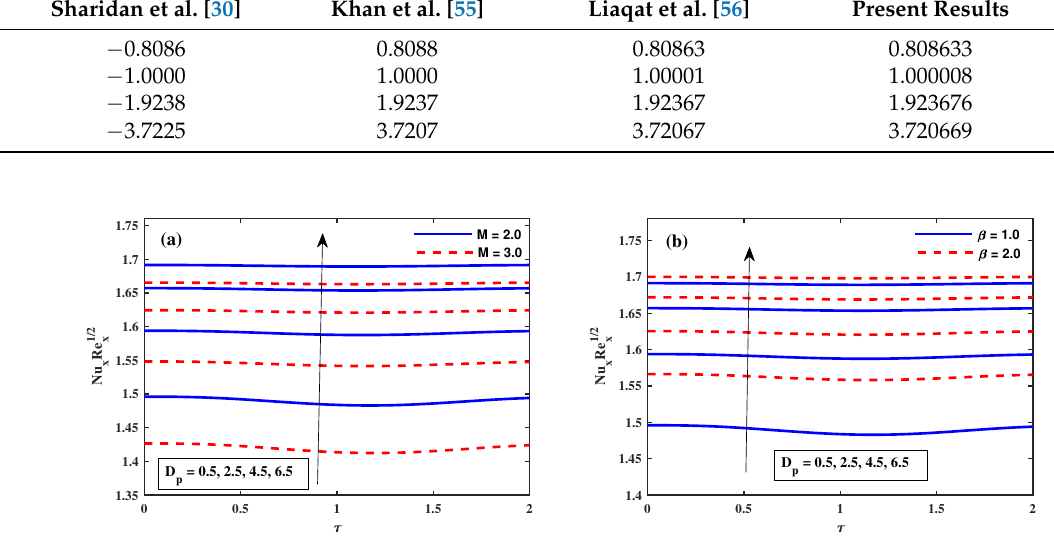
Figure 10. Fluctuation of Nu x Re 1/2 x against D p (nanoparticle radius), ( a ) M (magnetic field), and ( b ) β (material parameter).